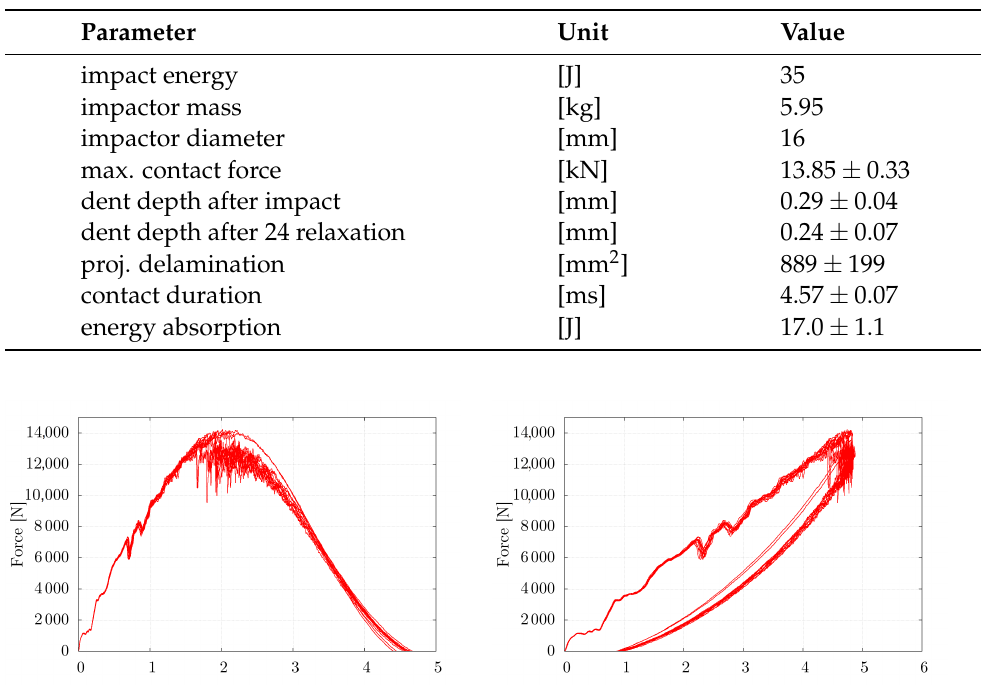
Table 1. The characteristic values and the respective standard deviation of the coupon impact tests.